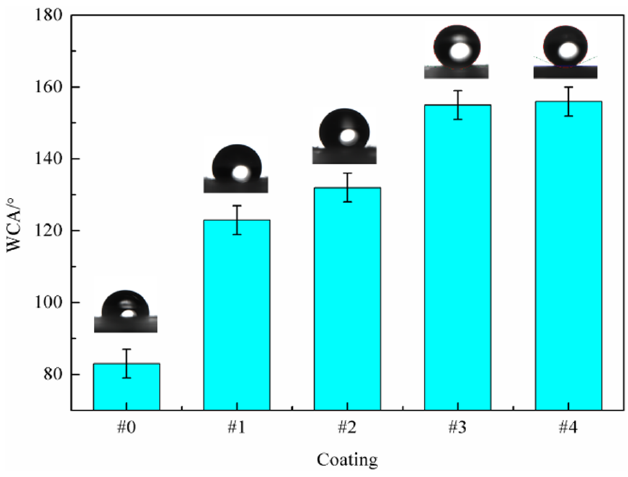
Figure 2. WCAs of different WPU SCCs with modified fillers.